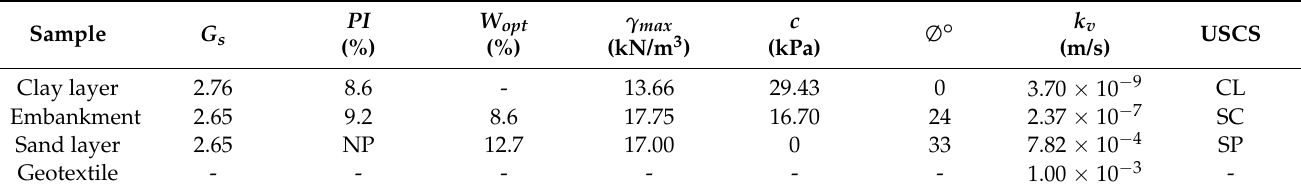
Table 1. Physical and mechanical properties of samples used in the model.